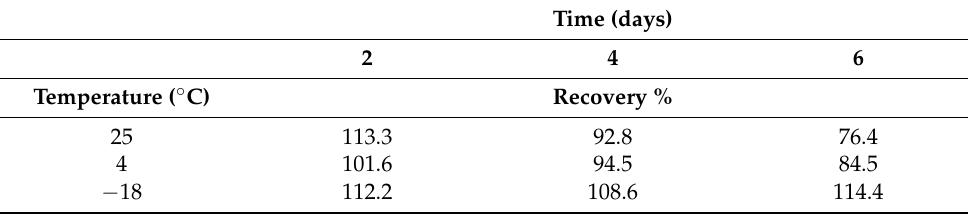
Table 2. Stability of the devices (Na 2 SO 3 + NaOH + MTB) under different storage